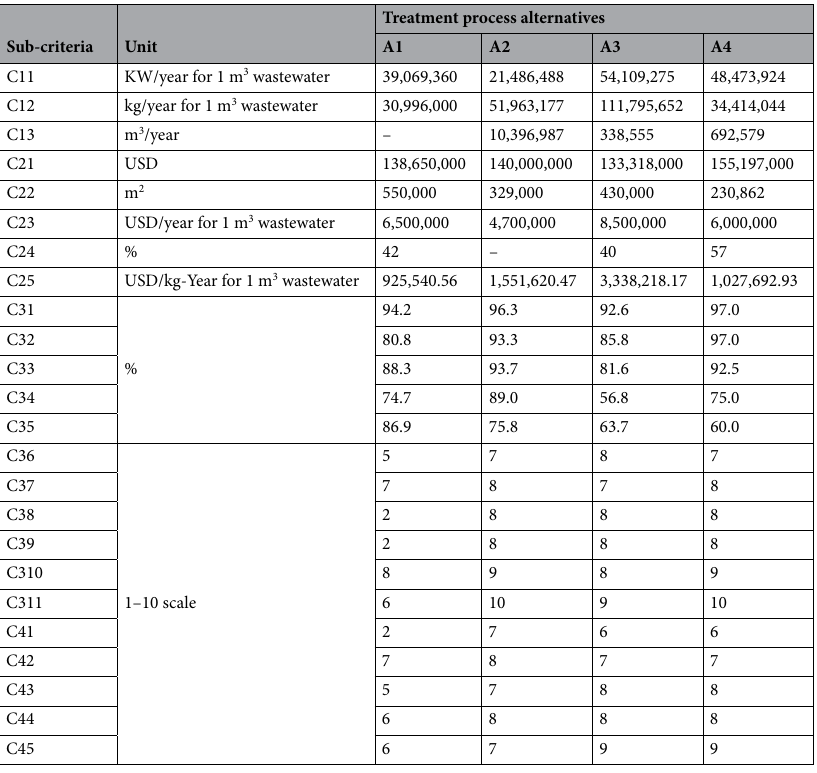
Table 4. Crisp and linguistic data of sub-criteria for WWTP technology selection